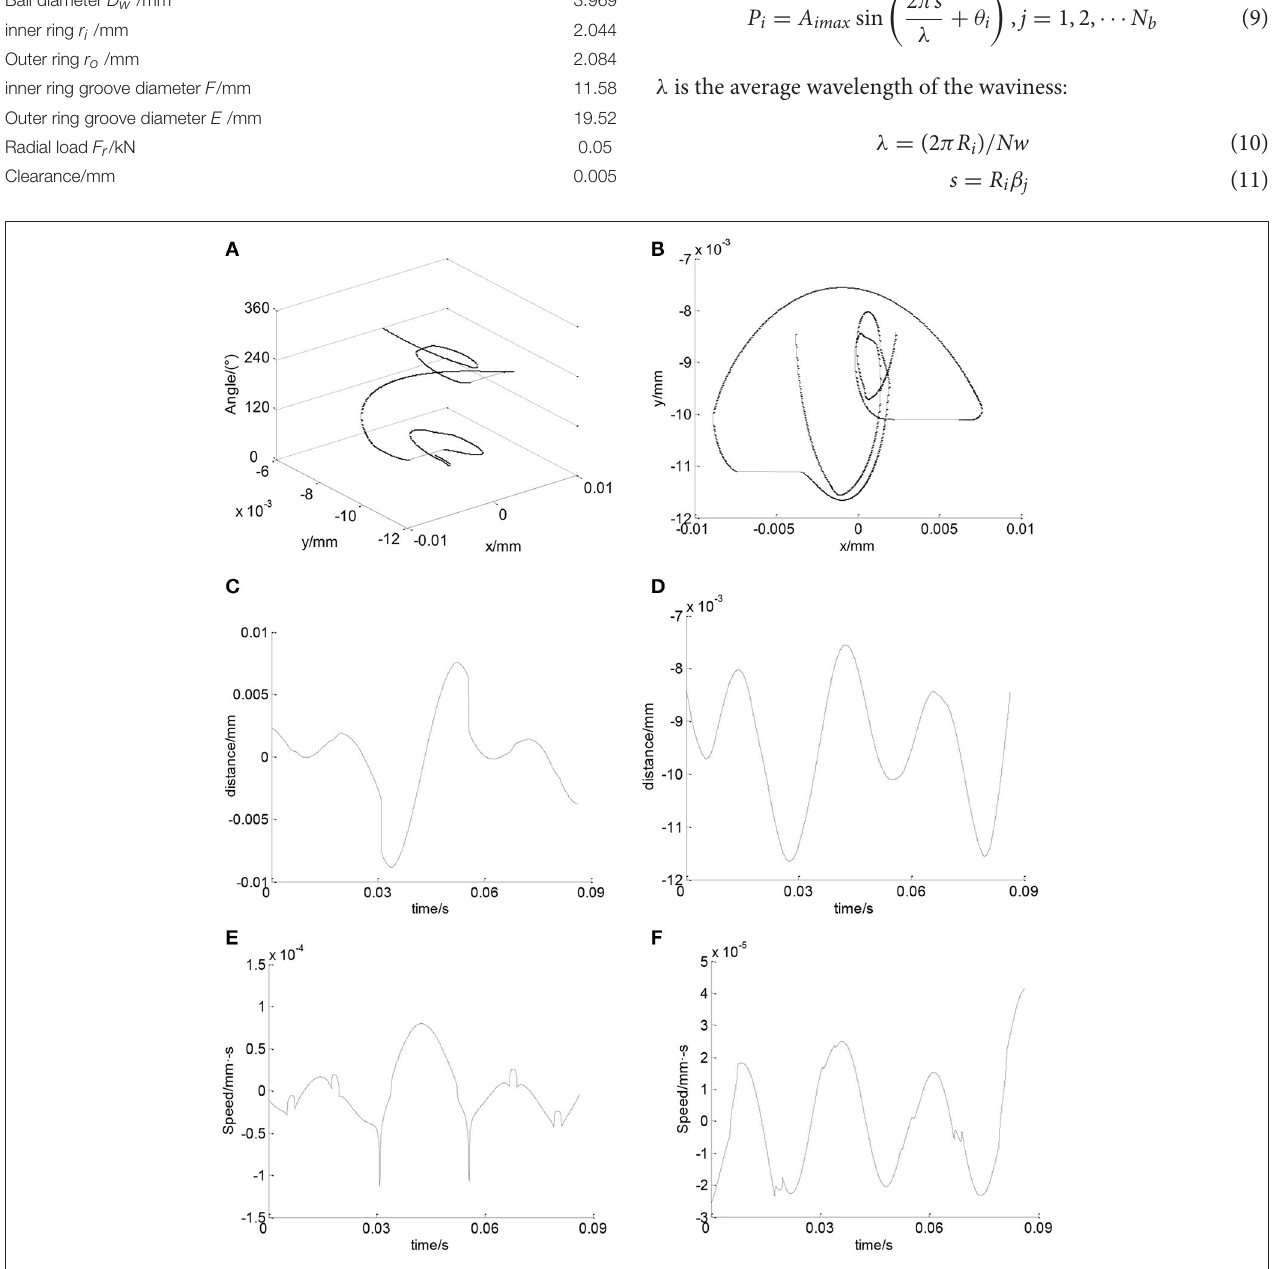
FIGURE 9 | Axis center orbit and velocity of the inner ring center. (A) Axis center orbit of the inner ring. (B) Axis center orbit of the inner ring in XOY plane. (C) Axis center orbit of the inner ring in X direction. (D) Axis center orbit of the inner ring in Y direction. (E) Speed of the inner ring center in X direction. (F) Speed of the inner ring center in Y